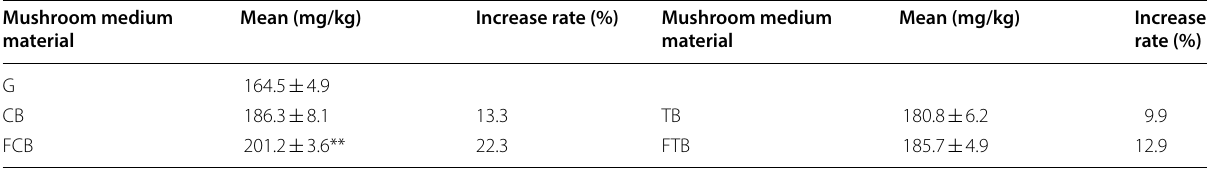
Table 3 L-carnitine content in oyster mushroom grown on various buckwheat